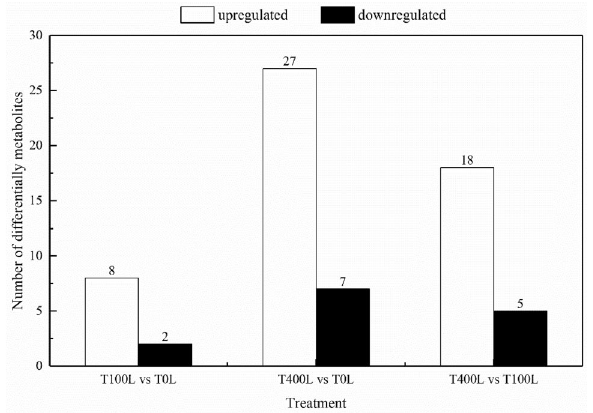
Figure 5. Number of differentially accumulating metabolites in the leaves of N. sibirica seedlings under salt as oxaloacetic acid, malic acid, fumaric acid, succinic acid and citric acid in the TCA cycle were significantly increased. Among them, the contents of citric acid and fumaric acid in the TCA cycle were about twice as high KEGG annotation of differentially accumulating metabolites.